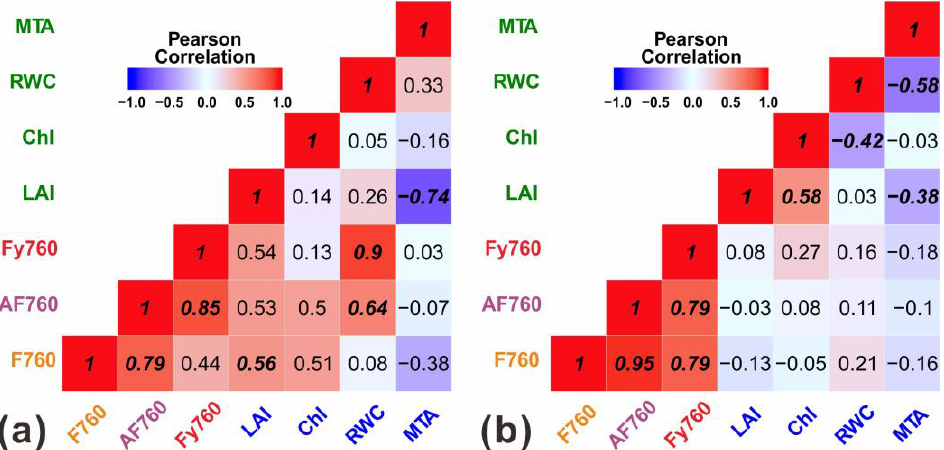
Figure 8. Relationships of growth parameters with F760, AF760, and Fy760 at noon at the diurnal scale. Left is wheat ( a ), while right is maize ( b ). The significant correlation between each of the two variables ( p -value < 0.05) is shown in italics/bold.